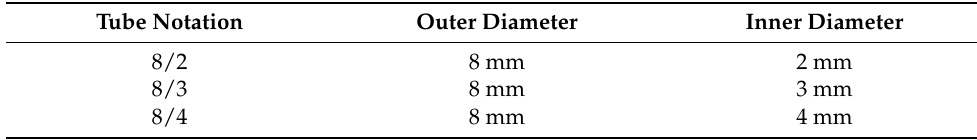
Table 1. Outer and inner diameters of quarts tubes